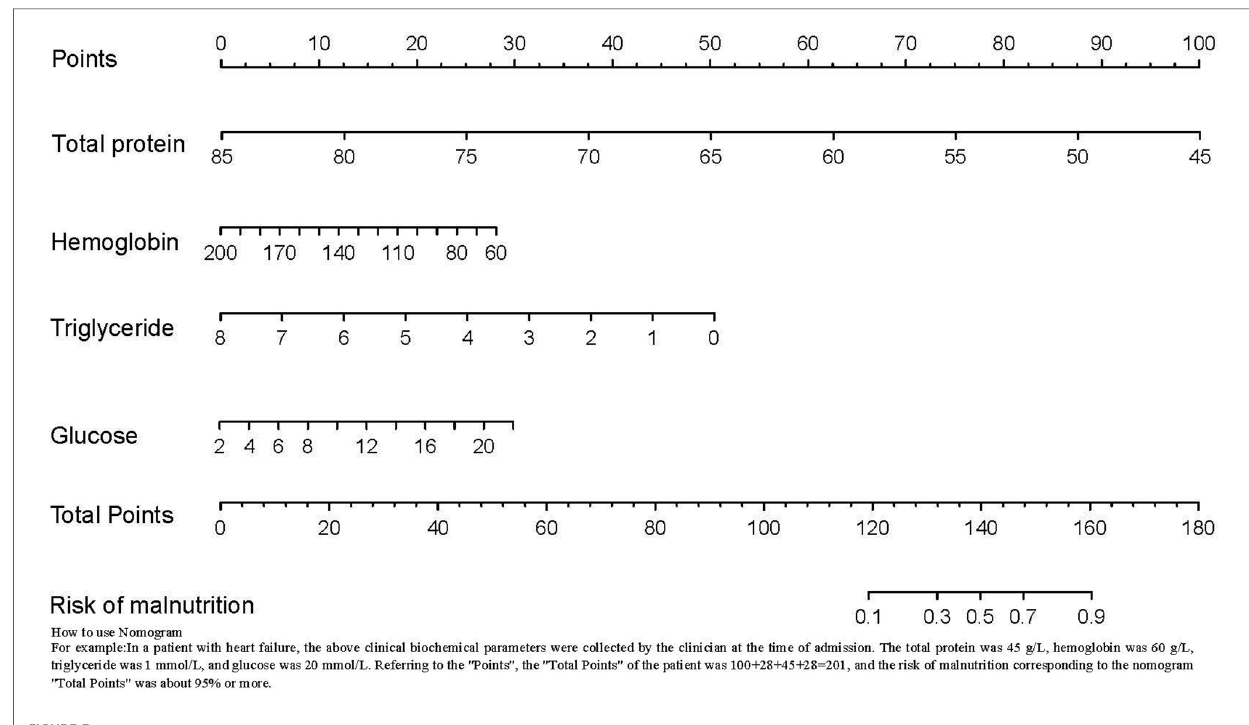
FIGURE 3 Risk prediction model for malnutrition. A risk prediction model for malnutrition in patients with HF based on risk factors was constructed and presented in the form of a line